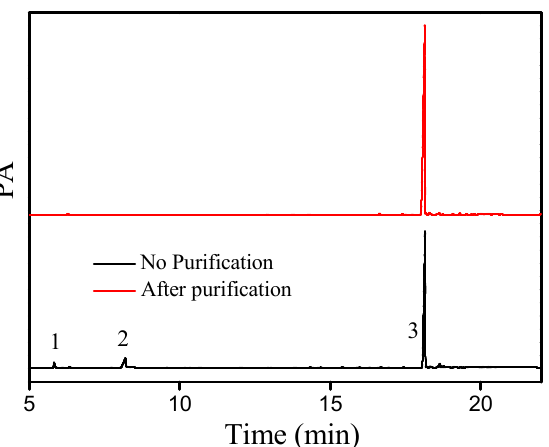
Figure 9. Gas chromatogram of cetyl oleate after esterification. (1) Cetyl alcohol, (2) oleic acid, (3) and cetyl oleate.